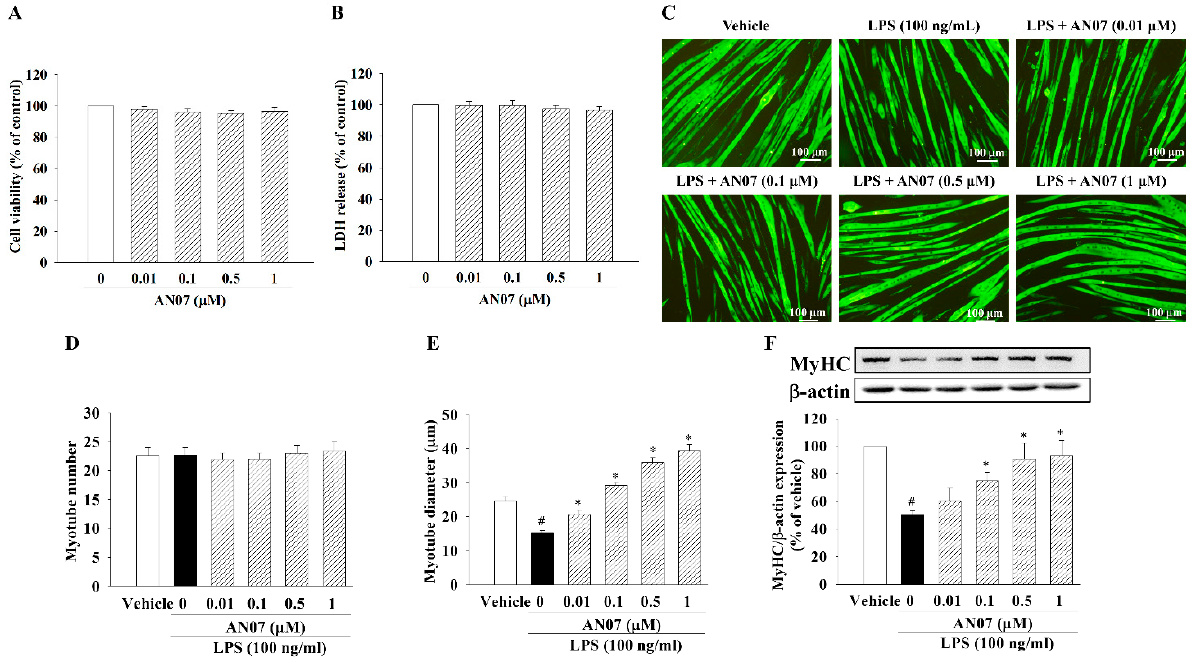
Figure 2. AN07 reduced LPS-induced C2C12 myotube atrophy. Myotubes were treated with AN07 (0.01–1 µ M) for 24 h. Effects of AN07 on ( A ) cell viability and ( B ) cytotoxicity of C2C12 myotubes were determined by MTT assay and LDH assay, respectively. ( C ) Immunofluorescence staining of MyHC (green) was performed to visualize C2C12 myotube morphology. Myotubes were pretreated with AN07 (0.01–1 µ M) for 1 h followed by LPS (100 ng/mL) treatment for 24 h. ( D ) Myotube number and ( E ) diameter were quantified. Scale bar = 100 µ m. ( F ) MyHC protein expression was detected by Western blotting. Densitometry analyses are presented as the relative ratio of protein/ β -actin protein and are represented as percentages of the control group. Data represent the mean ± SEM from six independent experiments (n = 6). # p < 0.05 vs. control group (vehicle only); * p < 0.05 vs. LPS-treated group according to one-way ANOVA followed by a Tukey post-hoc test ( D , E ) or Kruskal–Wallis test followed by Dunn’s test ( A , B , F